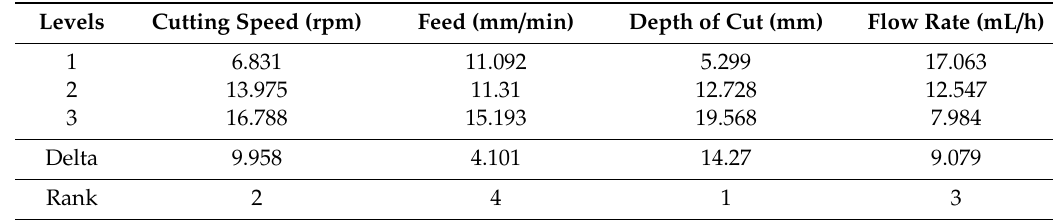
Table 5. Response table for material removal